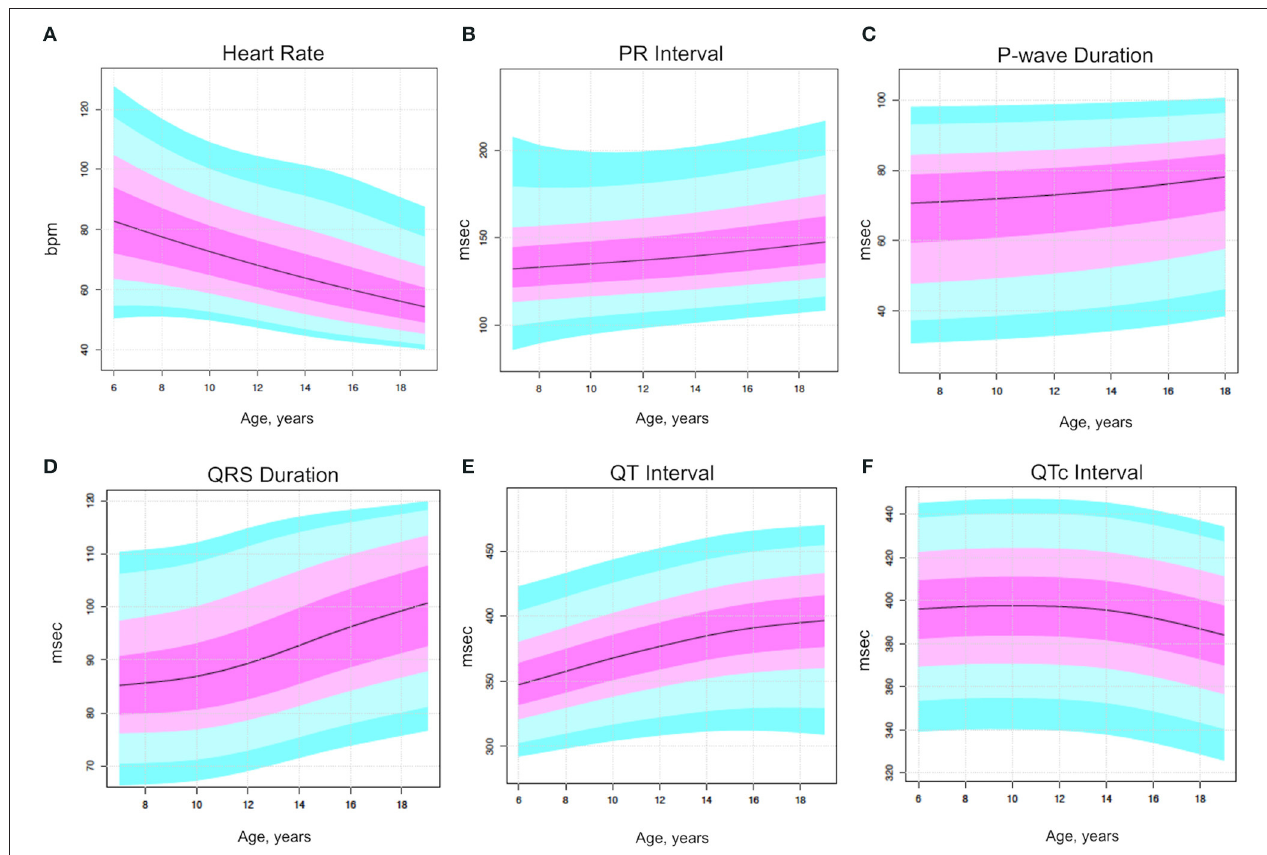
FIGURE 1 | Centile rainbow plots for heart rate (top left panel), P wave duration (right panel), PR (mid-left panel), QRS (mid-right panel), QT (bottom left panel), and QTc (bottom right panel), expressed as median and quartile and age ranges. (A) Heart rate. (B) P wave duration. (C) PR duration. (D) QRS duration. (E) QT duration. (F) QTc